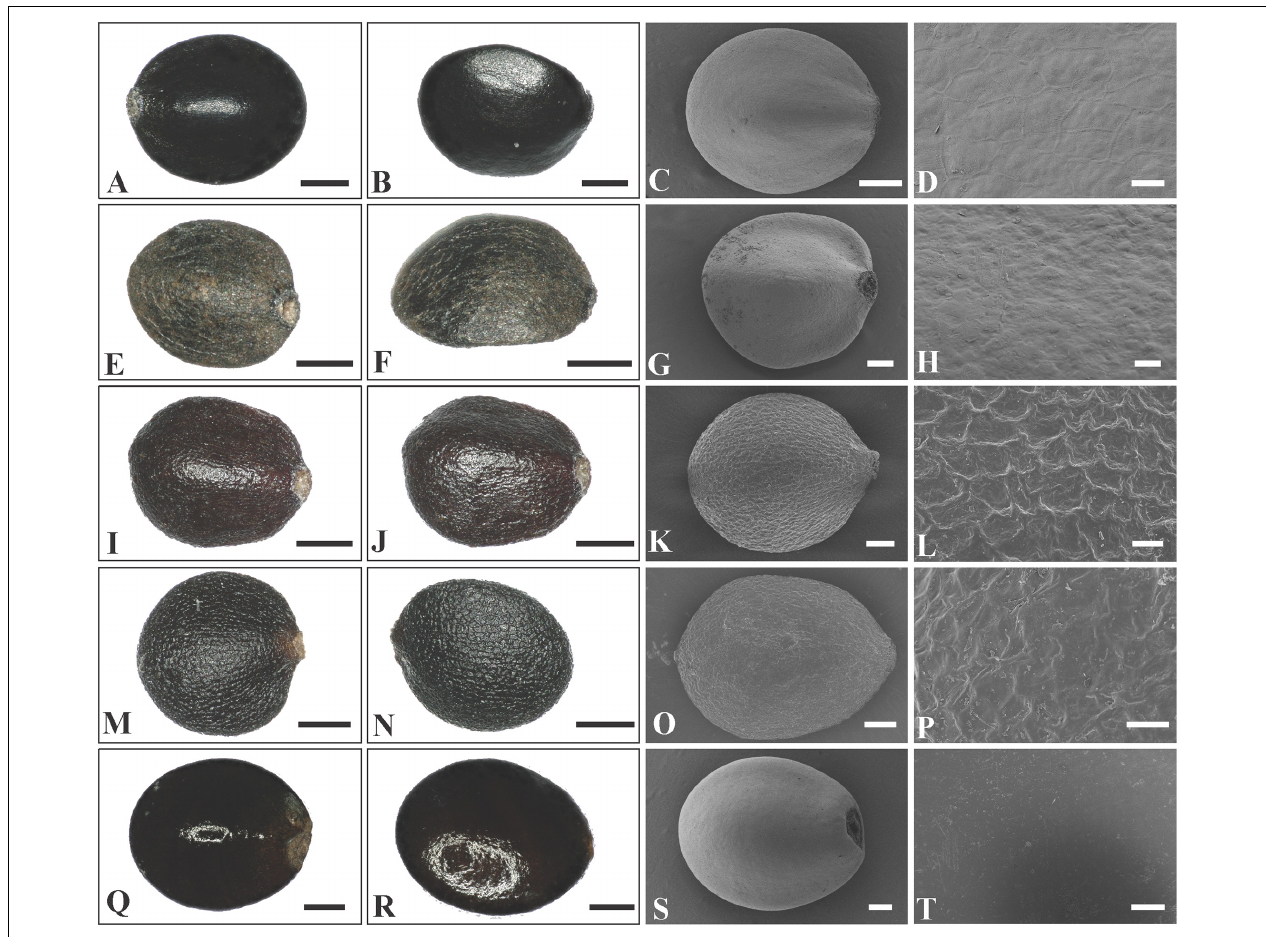
FIGURE 5 | LM and SEM micrographs of mericarps of Pogostemon and Anisomeles . (A–D) P. chinensis ( Guo et al., 12CS5297 ), (E–H) P. glaber ( Li Yongliang, LiYL1637 ), (I–L) P. brachystachyus ( Sun Xingxu, SunXX154 ), (M–P) P. amaranthoides ( Sun Xingxu, SunXX148 ), (Q–T) Anisomeles indica ( Liu et al., SCSB-B-0000020 ).— Scale bars: (A–C,E–F,I–J,M–N,S) 200 µ m; (D,H,L,P) 20 µ m; (G,K,O) 100 µ m; (Q,R) 400 µ m; (T) 40 µ